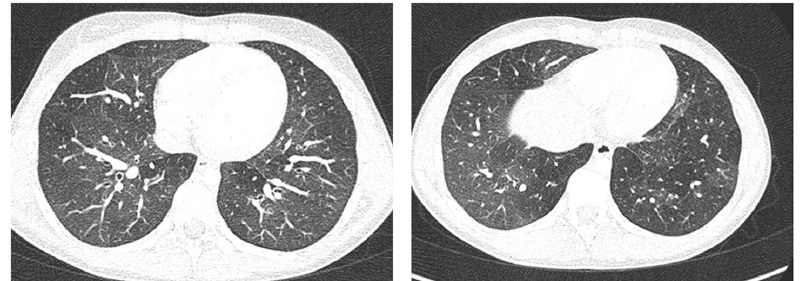
Figure 8. A representative coronal section from thoracic computed tomography (CT) scan reveals: thickening of the bronchial walls bilaterally, with filling of the bronchial lumen predominantly in the apical segment of the right upper lobe; picture of diffuse inhomogeneity of parenchymal density with diffuse and bilateral hypodense areas in relation to air trapping correlated to a picture of recurrent airway inflammation.